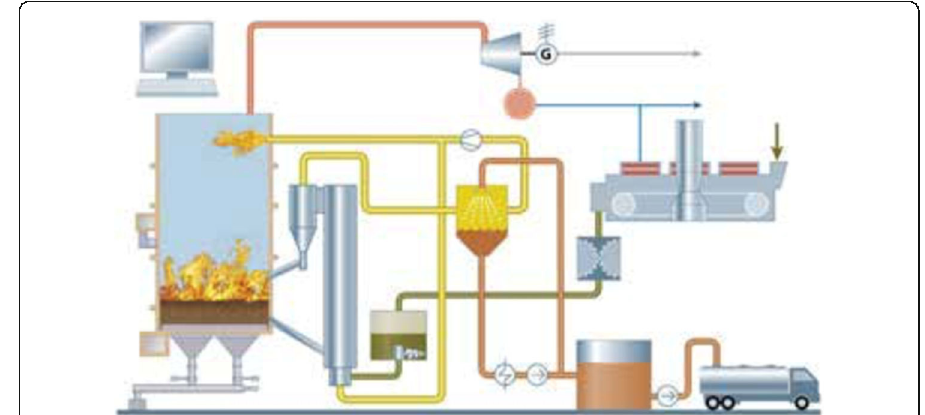
Fig. 1 CHP integrated pyrolysis process in